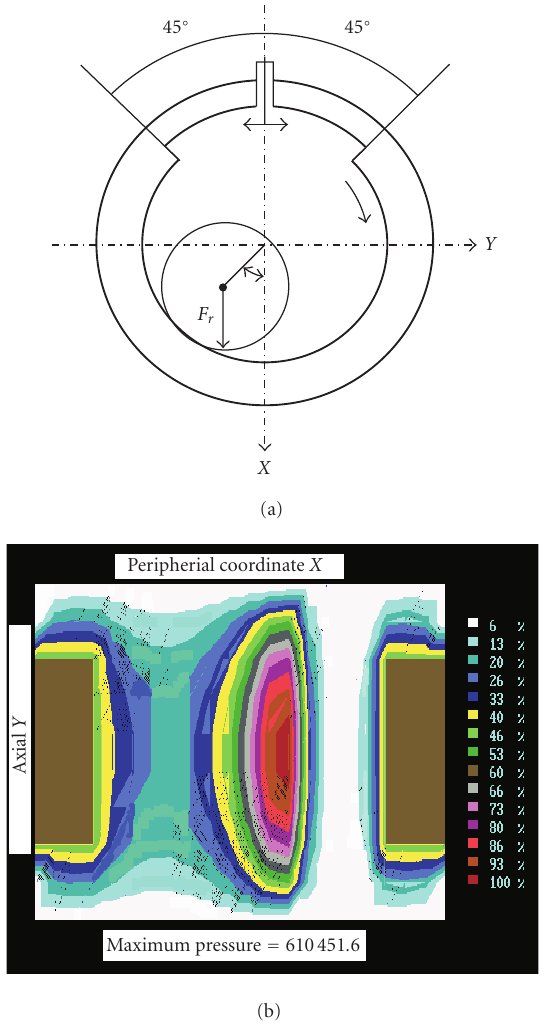
Figure 1: The analyzed bearing: (a) physical description and geo- metrical configuration and (b) typical pressure field used to com- pute coe ffi cients; notice the feed port pressurized area at P s =